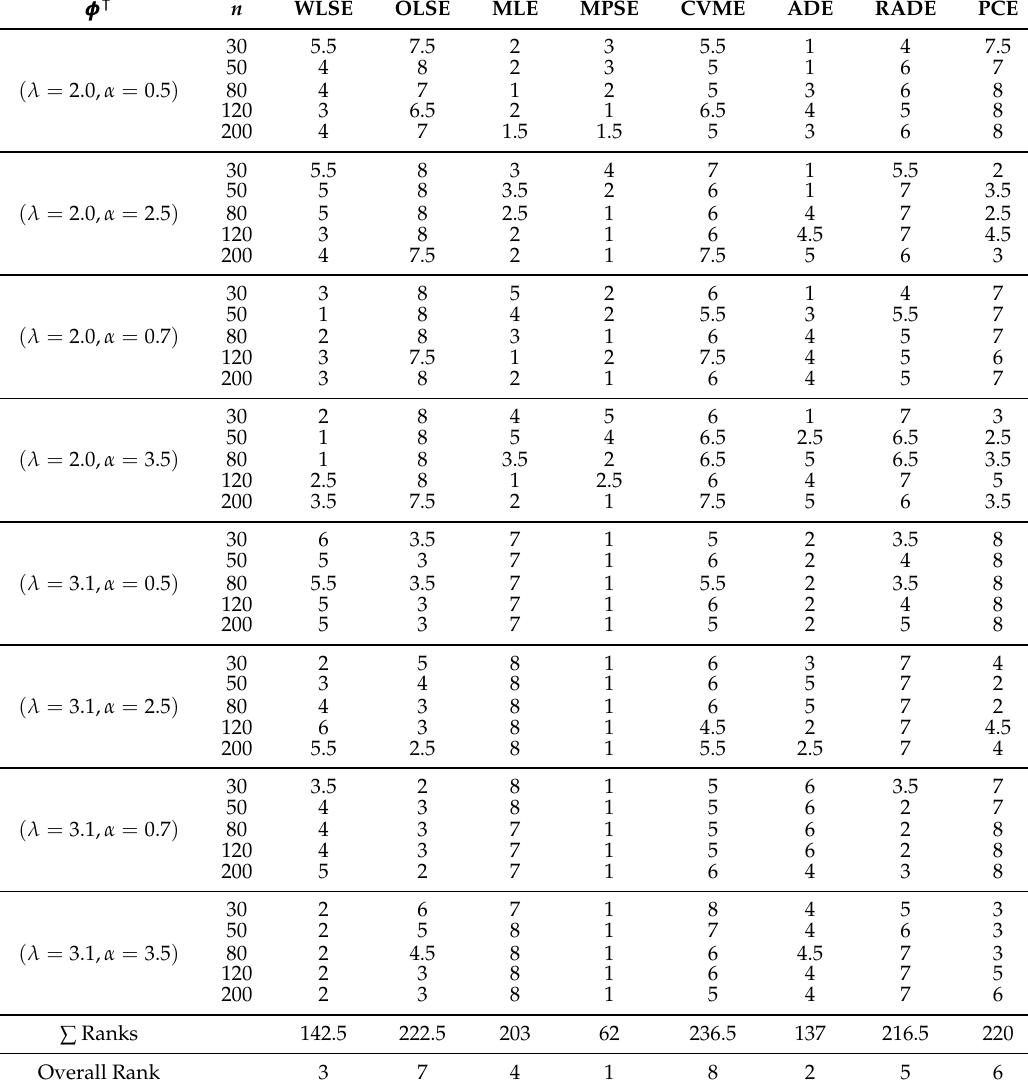
Table 10. Partial and overall ranks of all estimation methods for various combinations of φφφ . φφφ